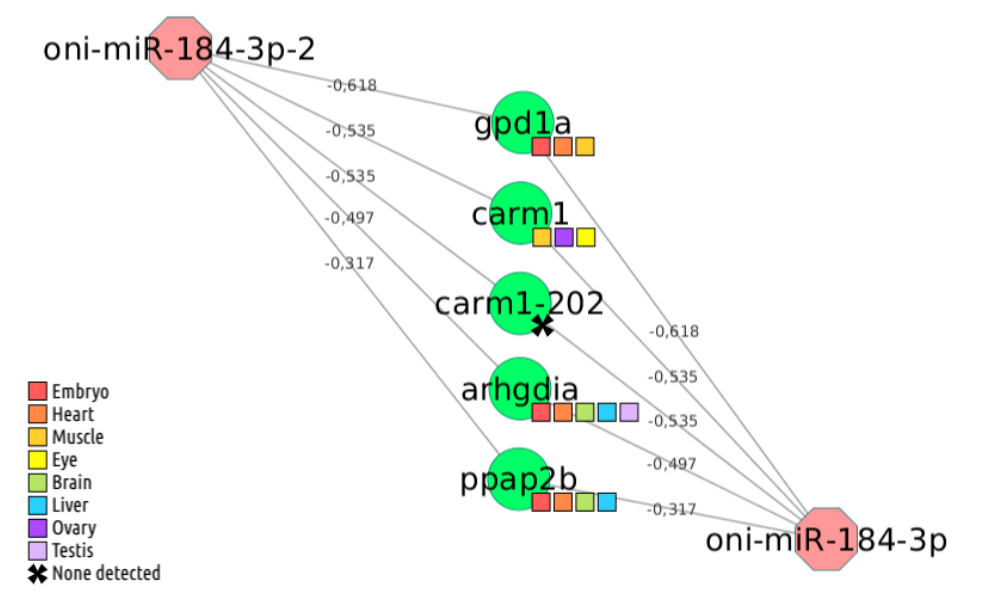
Figure 2. Predicted target network interactions of oni-miR-184-3p and oni-miR-184-3p-2. Red octagons symbolize the miRNAs, green circles the target genes, and gray lines represent predicted interactions by TargetScan v6.0 following the context+ score values over lines (lower is better). Target gene expression was estimated using public transcriptome datasets, and its presence in the sample was represented by colored squares (see Materials and Methods, Target Prediction